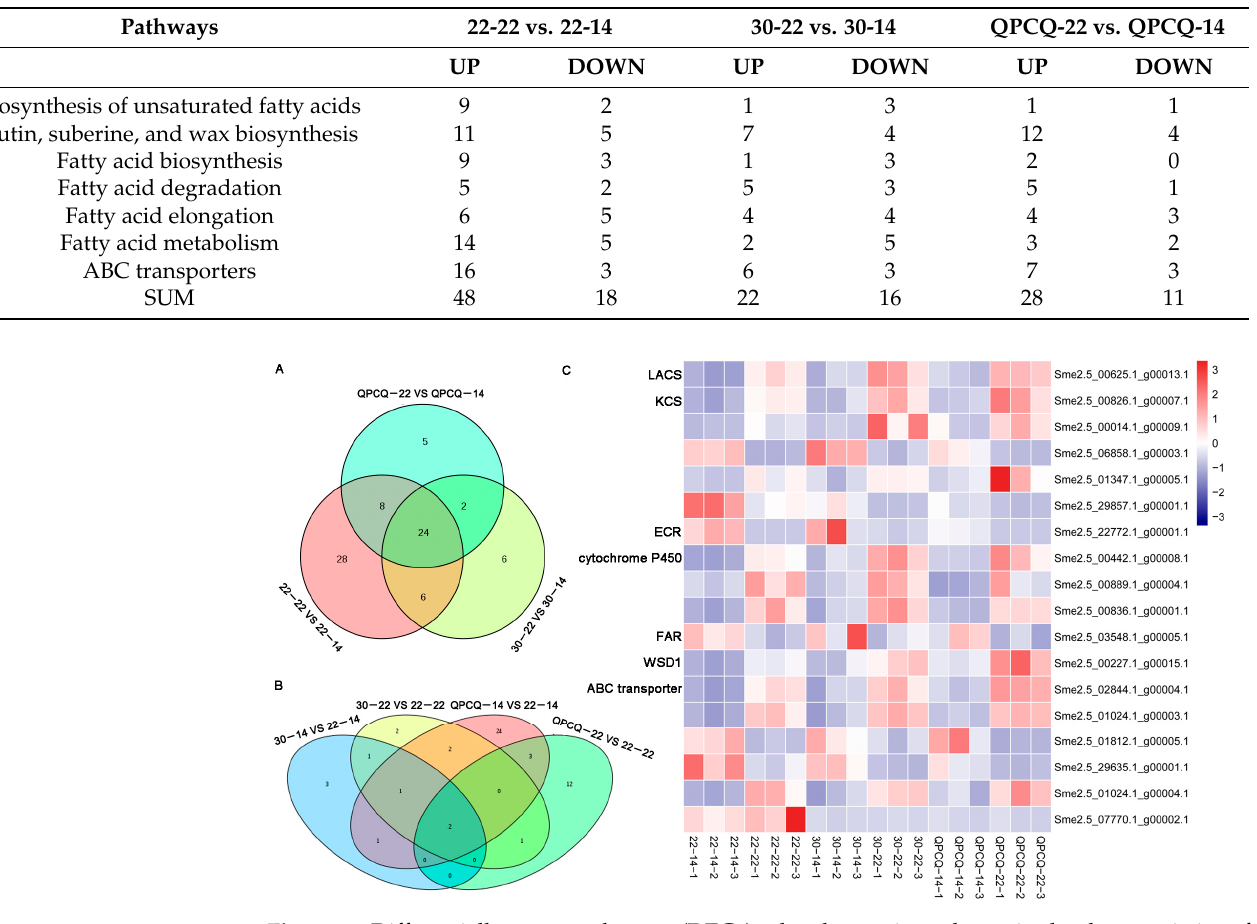
Figure 6. Differentially expressed genes (DEGs) related to cutin and wax in the three varieties of eggplant. Venn plots of 22 DAP vs. 14 DAP in three varieties ( A ), groups 30 vs. 20 and QPCQ vs. 20 ( B ). ( C ) Heat map of DEGs related to cutin and wax in eggplants of different brightness.